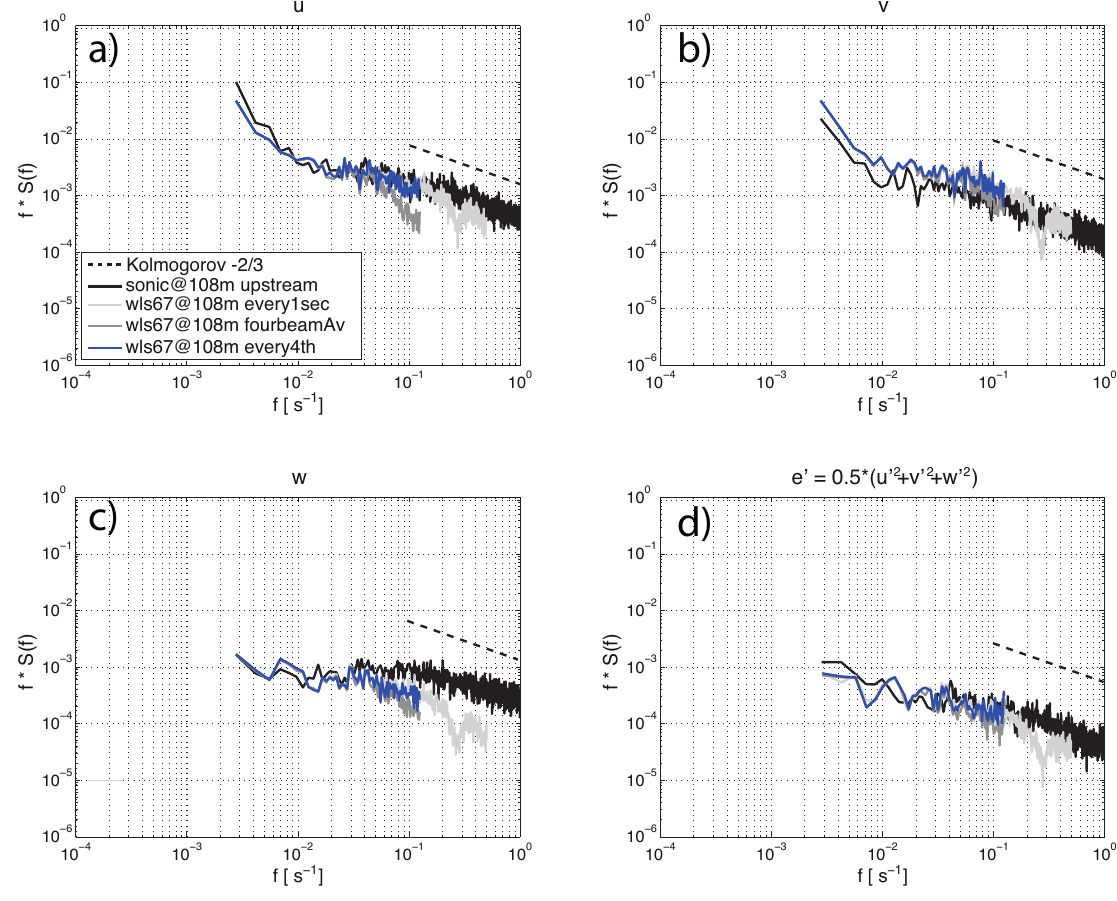
Figure 2. Energy spectra of four hours on 4 March 2014 during free stream conditions ( dir mean = 240 ◦ ) of the along-wind ( a ), cross-wind ( b ) and vertical component ( c ) and TKE ( d ). Black colors show data from the sonic anemometer, and blue and grey colors show Windcube wls67 data, all at 108 m. The dashed line indicates the − 2/3 Kolmogorov